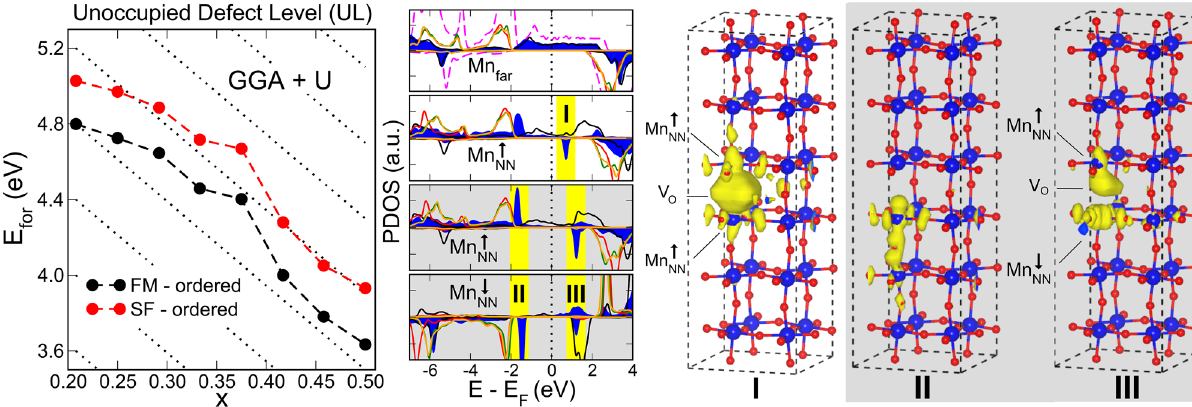
Figure 5. Left Panel: Formation energy for an isolated oxygen vacancy as a function of Sr doping for GGA + U calculation ( U = 4.5eV ), with ordered Sr distribution. Dotted black lines as a grid depict the slope of UL for bare GGA. Central Panel: 3d Mn PDOS for low doping (same notation as in Fig. 4). Right Panel: Isosurfaces of electronic local density of states for the energy regions labelled I, II and III in the central panel. To highlight the defect level, only the spin down component is